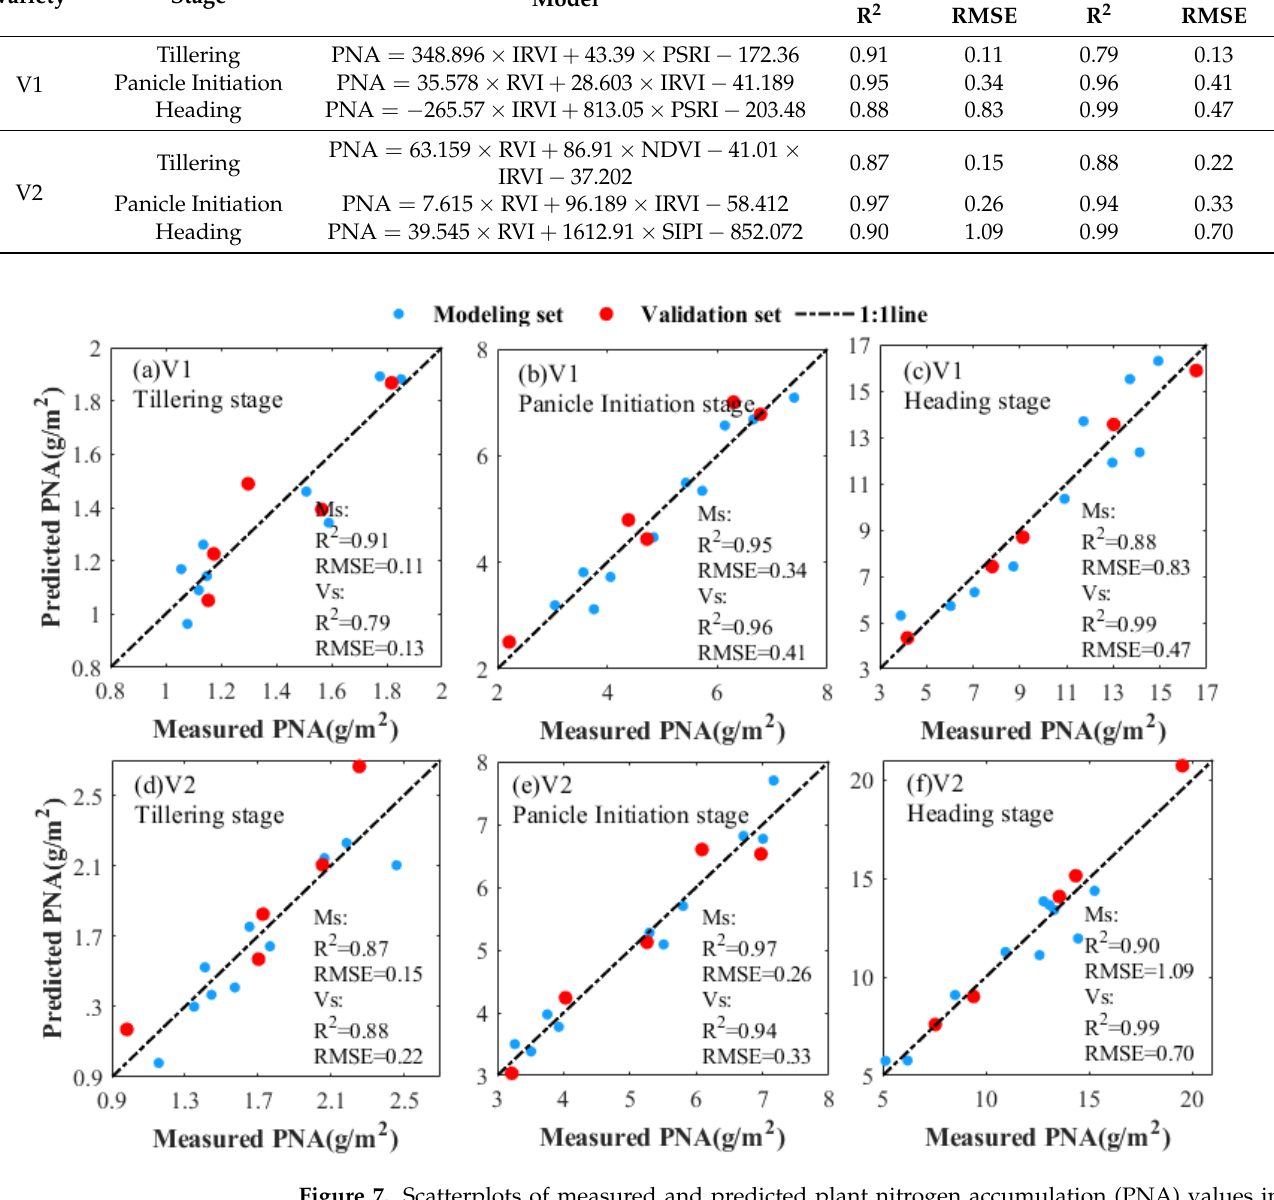
Figure 7. Scatterplots of measured and predicted plant nitrogen accumulation (PNA) values in variety V1 (Meixiangzhan 2) at ( a ) the tillering stage, ( b ) panicle initiation stage, and ( c ) heading stage; and in variety V2 (Wufengyou 615) at ( d ) the tillering stage, ( e ) panicle initiation stage, and ( f ) heading stage.